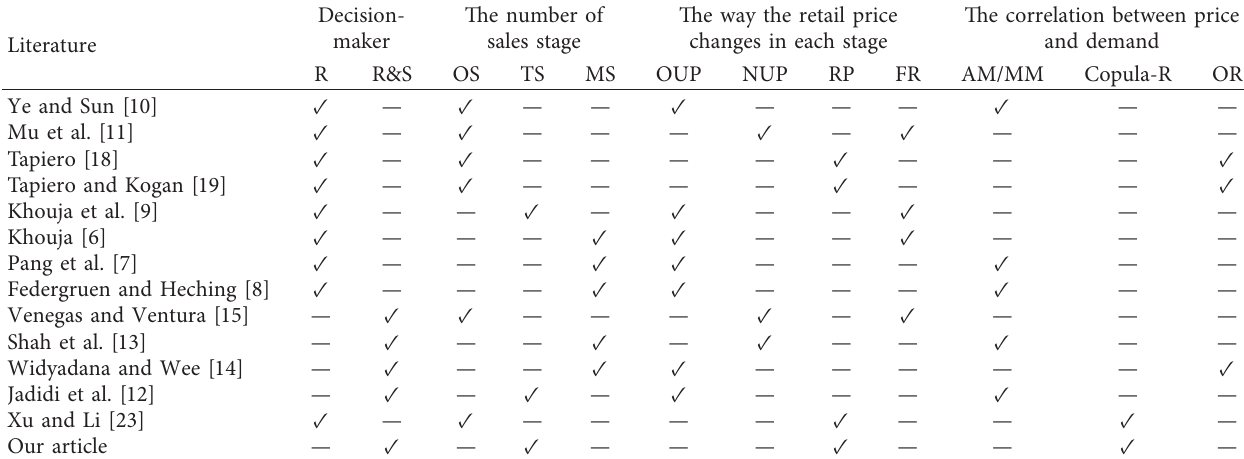
Table 1: Major characteristics of ordering models from selected literature